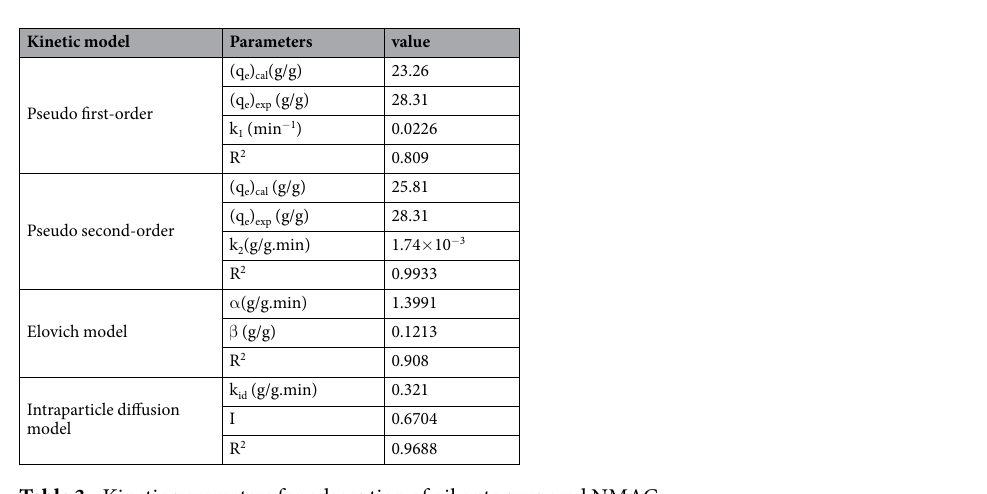
Table 3. Kinetic parameters for adsorption of oil onto prepared